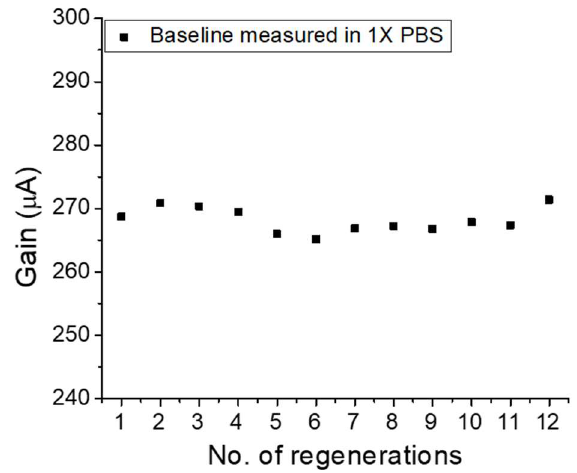
Figure 5. Gain versus number of regenerations after EV detection of HEMT biosensor.